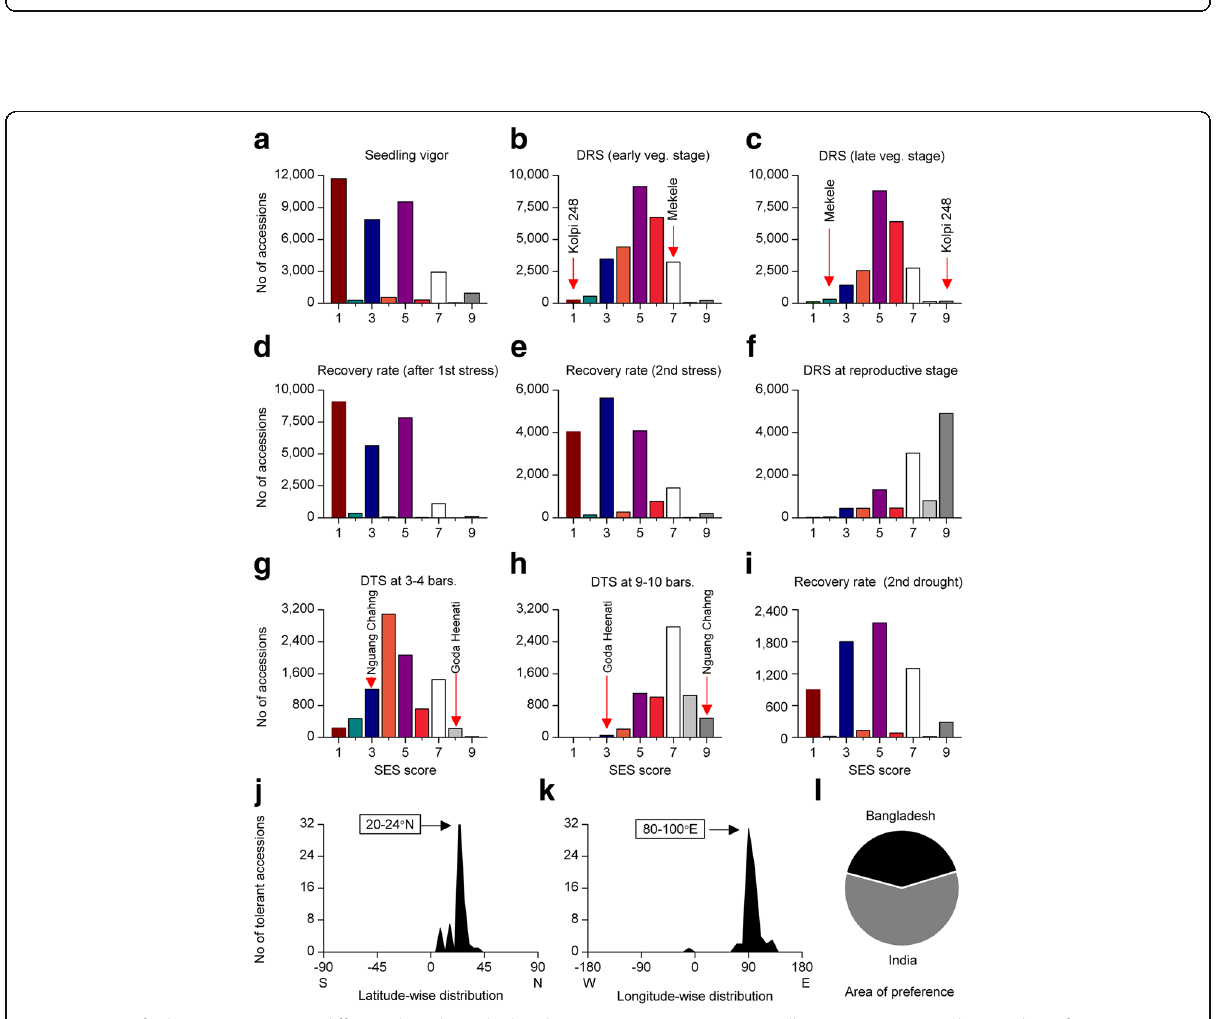
Fig. 8 Extent of tolerant accessions in different drought and related screening experiments. a Seedling vigour scoring taken 15 days after sowing in upland culture, b Drought resistance score (DSR) at early vegetative (tillering) stage (50 to 60 days) of both the early and late-maturing varieties, c Drought resistance score at late vegetative stage (80-100 days) of late-maturing varieties, d Rate of recovery after the 1st stress, e Rate of recovery after the 2nd stress, f Drought resistance score at reproductive stage, g Drought tolerance score of accessions at 3-4 bars soil moisture, h Drought tolerance score of accessions at 9-10 bars soil moisture, i Rate of recovery after exposure to 2nd drought. Scores were taken after 10 days following soaking rain or watering j - k Geographic distribution pattern of drought tolerant accessions identified by direct selection, i.e., yield performance in field conditions, j Latitude-wise distribution, k Longitude-wide distribution, l Area of preference. List of tolerant accessions can be found in Additional file 4: Table